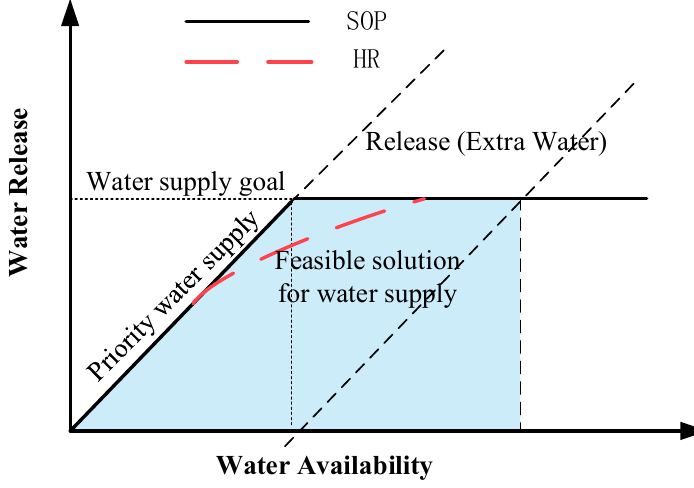
Figure 1. Standard Operation Policy and Hedging